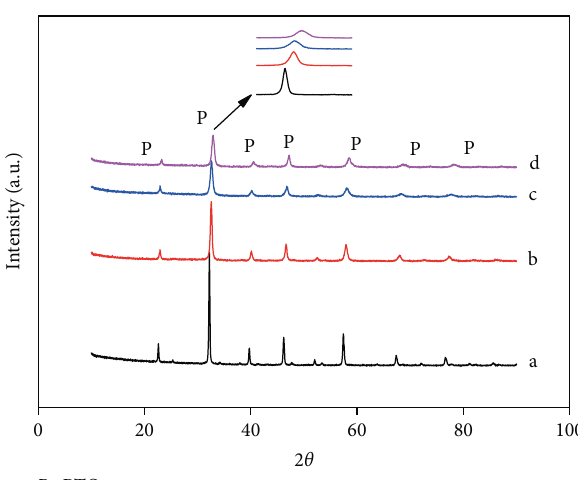
Figure 1: XRD patterns of (a) LaFeO (c) LaFe 0.5 Ni 0.5 O 3 , and (d) LaFe 0.3 Ni 0.7 O 3